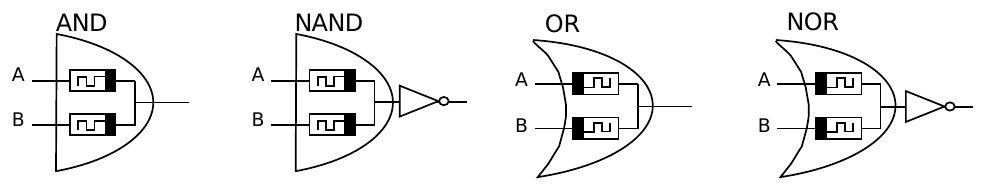
Figure 5. Schematic layout of MRL AND, NAND, OR and NOR gates.